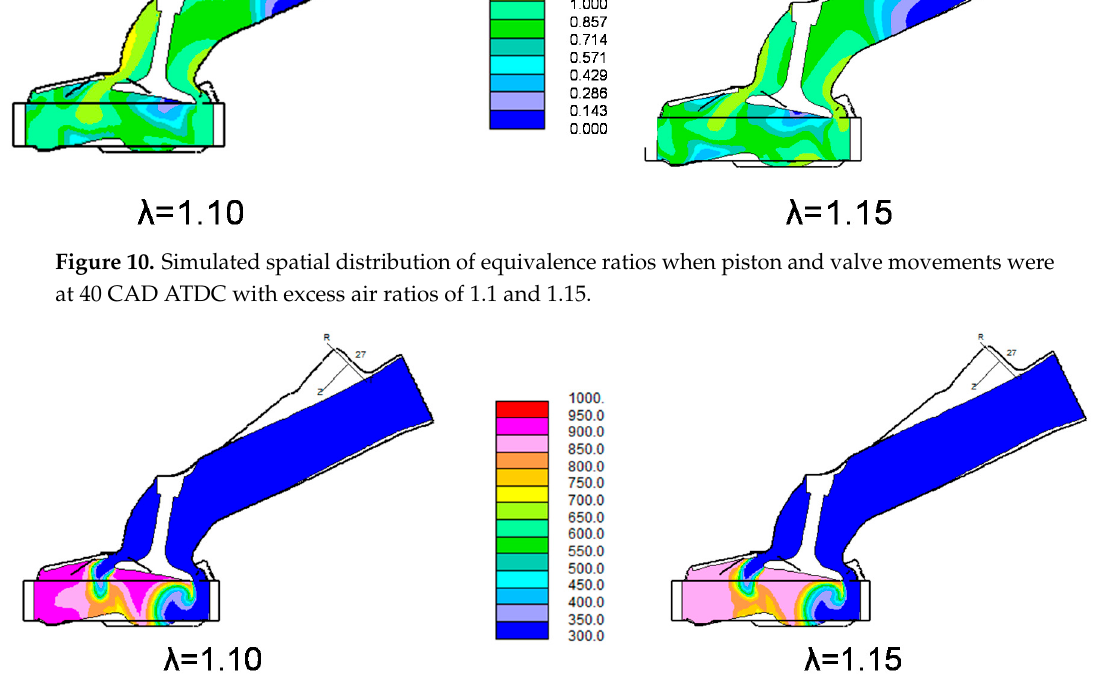
Figure 11. Simulated spatial distribution of temperature in Kelvin when piston and valve movements were at 40 CAD ATDC with excess air ratios of 1.1 and 1.15.